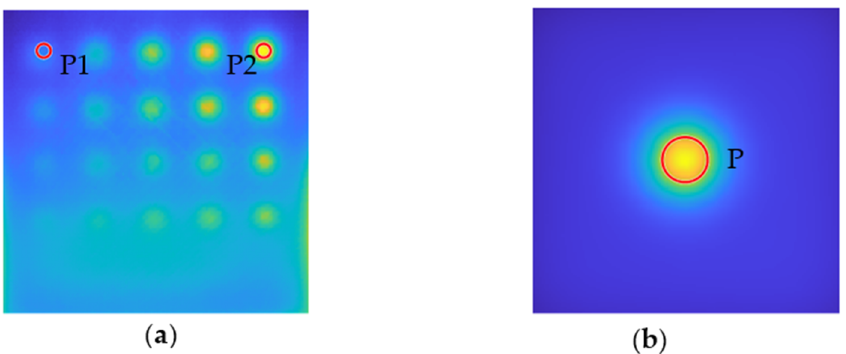
Figure 6. Localization of the areas taken under account in the optimization process. ( a ) Areas P1 and P2 localized on the chosen experimentally obtained thermogram, ( b ) area P localized on numerical thermogram.